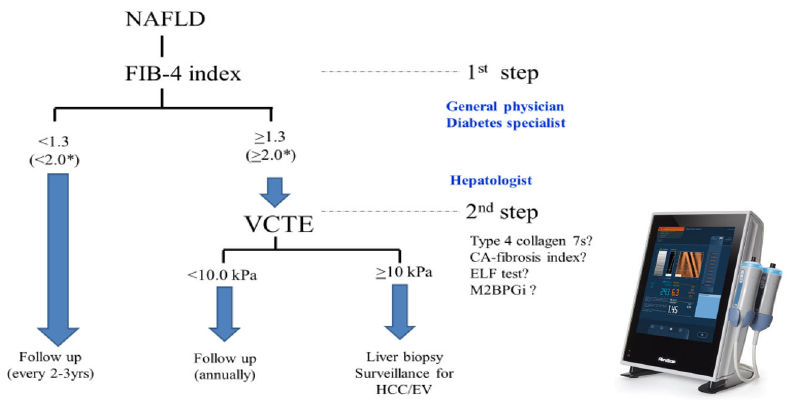
Figure 1. Two-step algorithm for determining NAFLD using the FIB-4 index (first step) and vibration-controlled transient elastography (VCTE) (second step). * older patients (aged 60 to 70 years or older); NAFLD: nonalcoholic fatty liver disease, FIB-4: fibrosis-4, VCTE: vibration-controlled transient elastography, ELF: enhanced liver fibrosis, M2BPGi: Mac-2 binding protein glycan isomer, HCC hepatocellular carcinoma, EV: esophageal